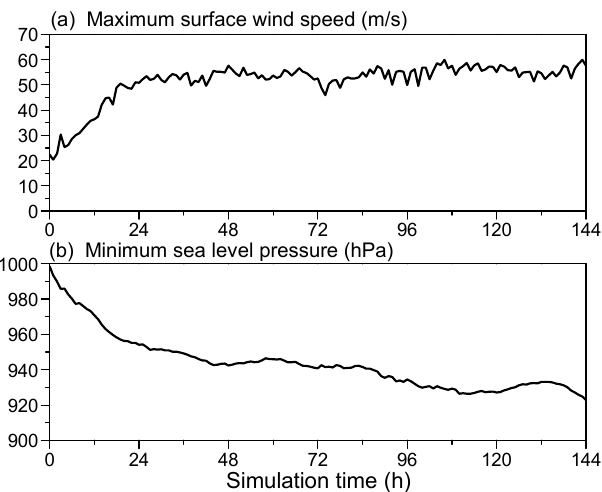
Figure 1. Time evolution of ( a ) minimum sea level pressure (hPa) and ( b ) maximum azimuthal mean wind speed at lowest model level (m s − 1 ). The figure incorporates the same information as Figure 1a in Ma et al. (2015)